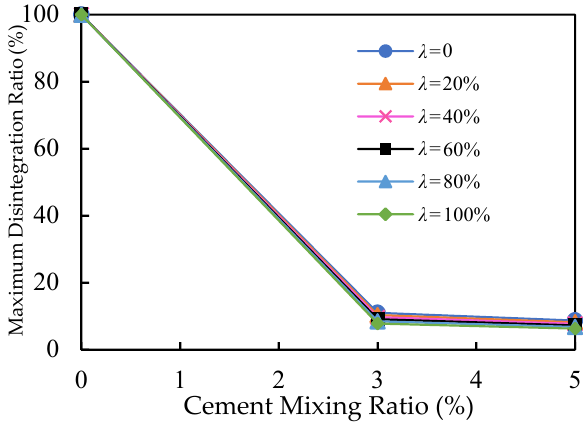
Figure 9. Variation rules of improved soil D m with cement mixing ratio.